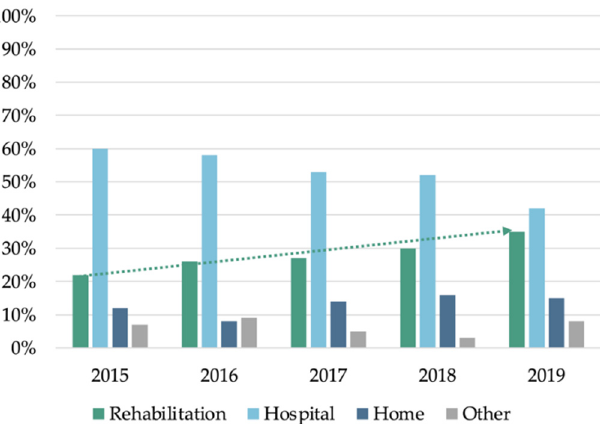
Figure 1. Direct pathway by year for patients with moderate–severe TBI ( n = 873). The percentage of patients following the direct pathway (rehabilitation) increased during the period. “Other” in- cludes general rehabilitation, nursing home and other.